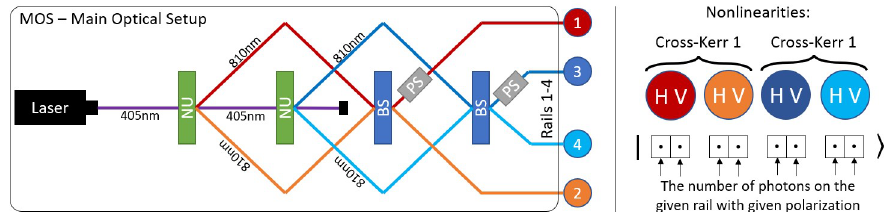
Figure 2. Experimental setup, showing ( left ) the main optical setup (MOS) and ( right ) the Fock state interpretation. The SPDC implemented by the nonlinear unit (NU), the beam splitter (BS), and the phase shifter (PS) are all indicated. The signal and output rails of the first NU are highlighted in red (1) and orange (2), respectively. The signal and output rails of the second NU are highlighted in dark blue (3) and light blue (4), respectively. The number of each output rail is shown, circled. The crossing of lines depicted in the setup should not occur in the actual experiment. The signal and output rails of each NU contain the stream of entangled photon pairs in the state | HV (cid:105)